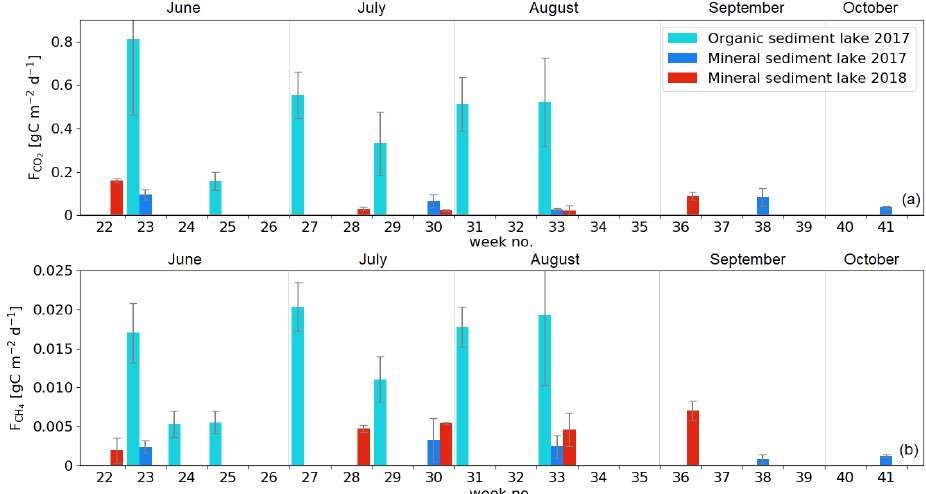
Figure 10. Weekly average lake CO 2 (a) and CH 4 (b) diffusive fluxes. Error bars represent the standard deviation of individual chamber measurements in each week.